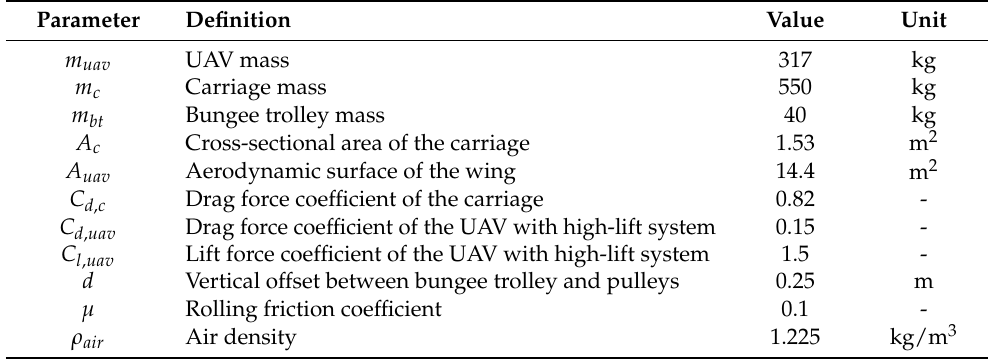
Table 5. The simulation